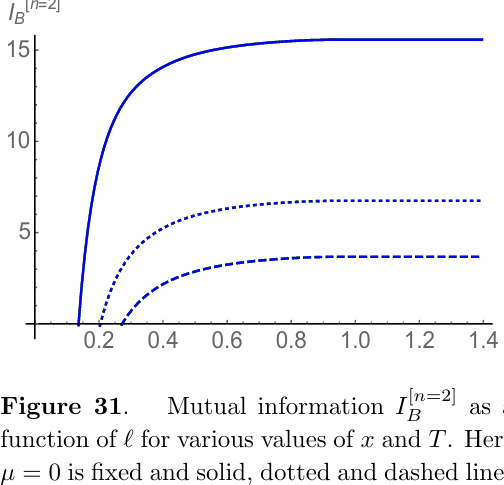
as a Figure 32 . Mutual information I [ n =2] B function of ‘ for various values of x and (cid:22) . Here T=T c = 0 : 9 is (cid:12)xed and solid, dotted and dashed lines correspond to x = 0 : 1, 0 : 15 and 0 : 20 re- spectively. The Red, green, blue and brown curves correspond to (cid:22) = 0, 0 : 1, 0 : 2 and 0 : 3 respectively. In units